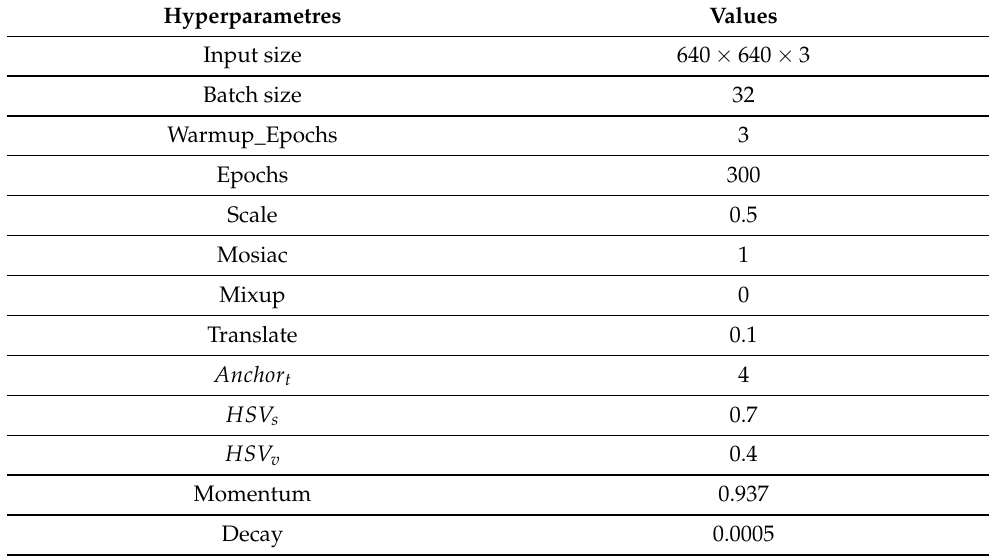
Table 1. Hyperparameters